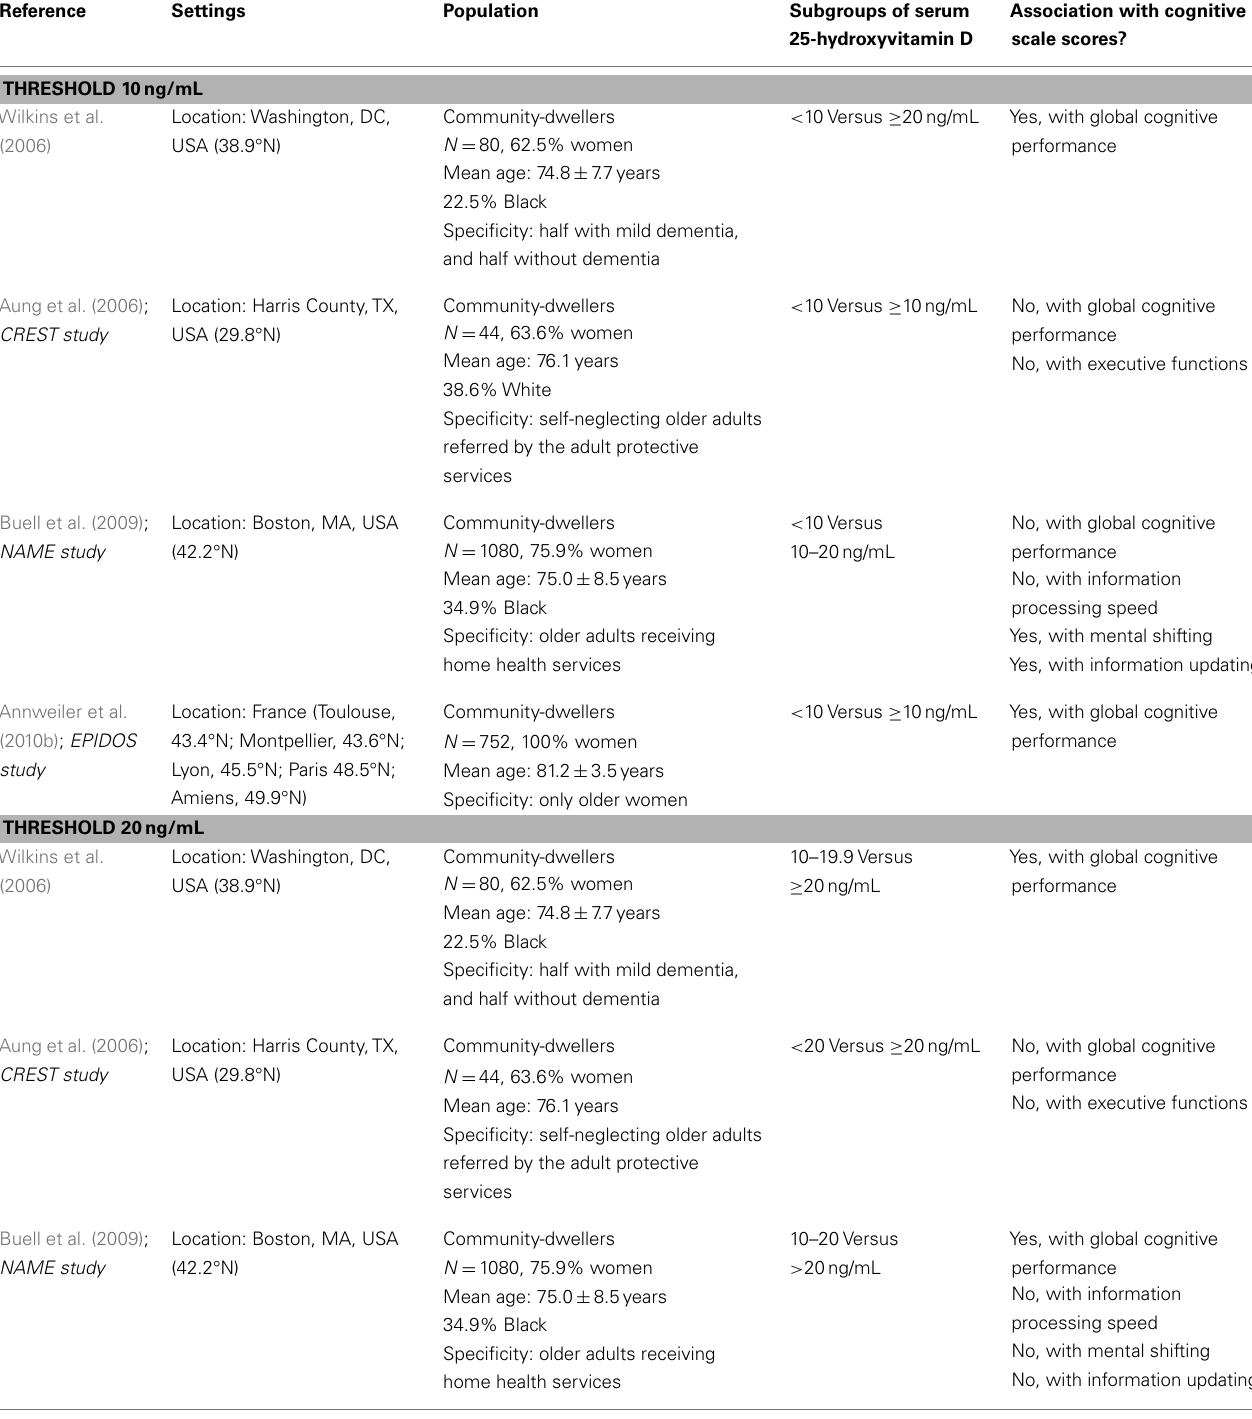
Table 1 | Summary of the observational studies examining the association between cognitive scale scores and hypovitaminosis D using a threshold at 10, 20, or